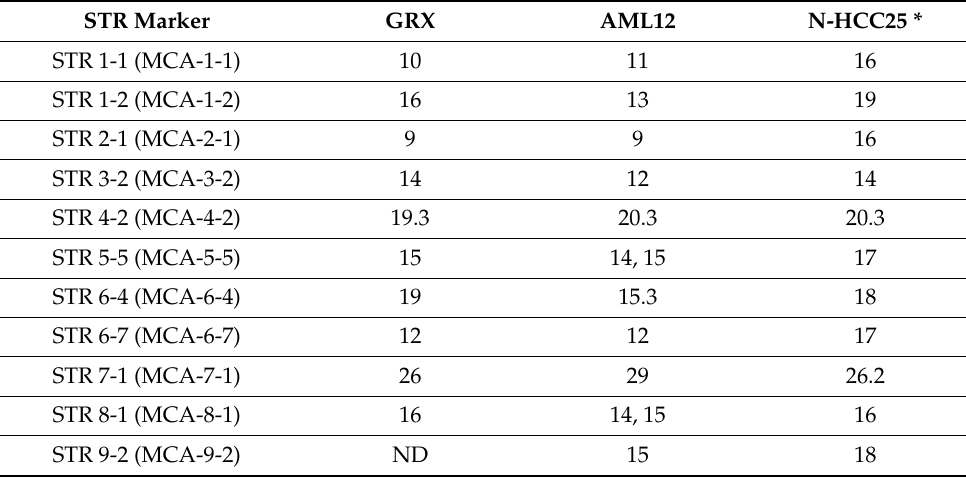
Table 5. Analysis of 19 STR markers in three different mouse cell lines.